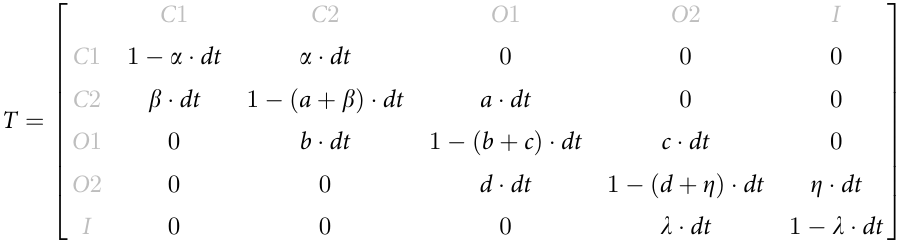
S2 Table. Patch-clamp results and statistical analysis. Resting potentials of current-clamp measurements, reversal potentials from voltage-ramp measurements (ramp potential) and reversal potentials derived from current-voltage curves (reversal potential) of the